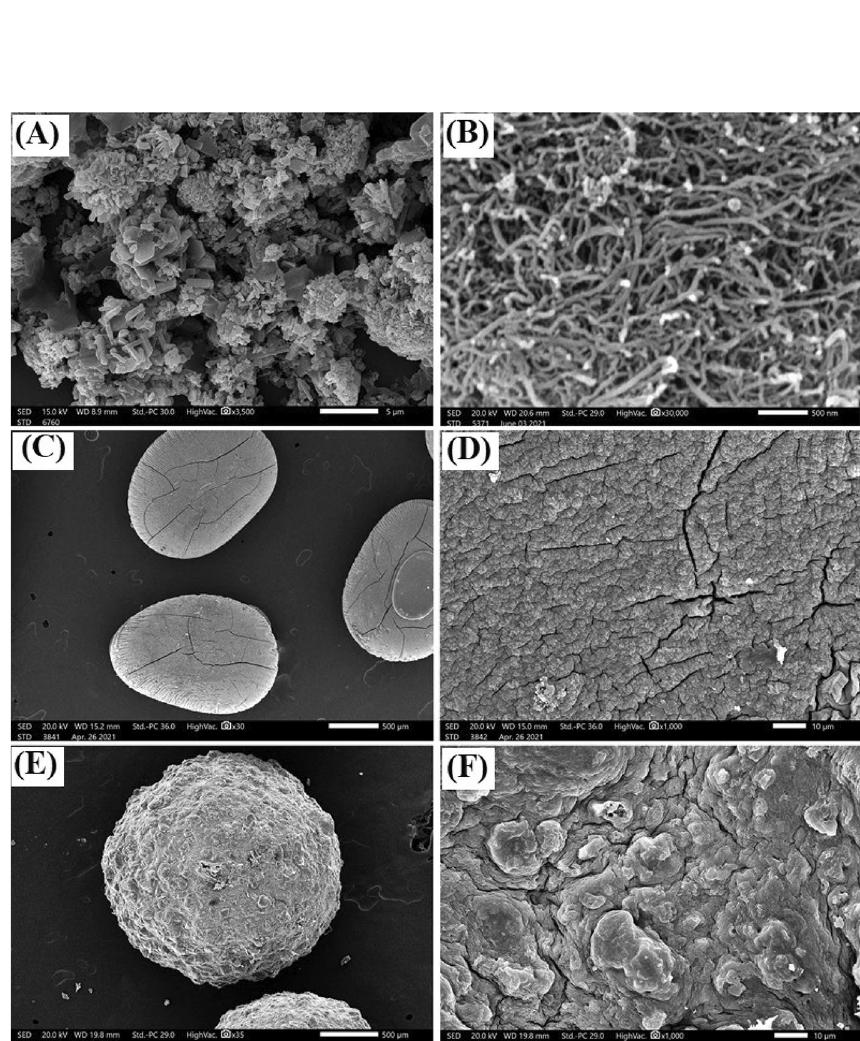
Figure 4. SEM images of ( A ) MIL-125(Ti)/MIL-53(Fe) binary MOF, ( B ) CNT ( C , D ) alginate microbeads and ( E , F ) MIL-125(Ti)/MIL-53(Fe)/CNT@Alg composite